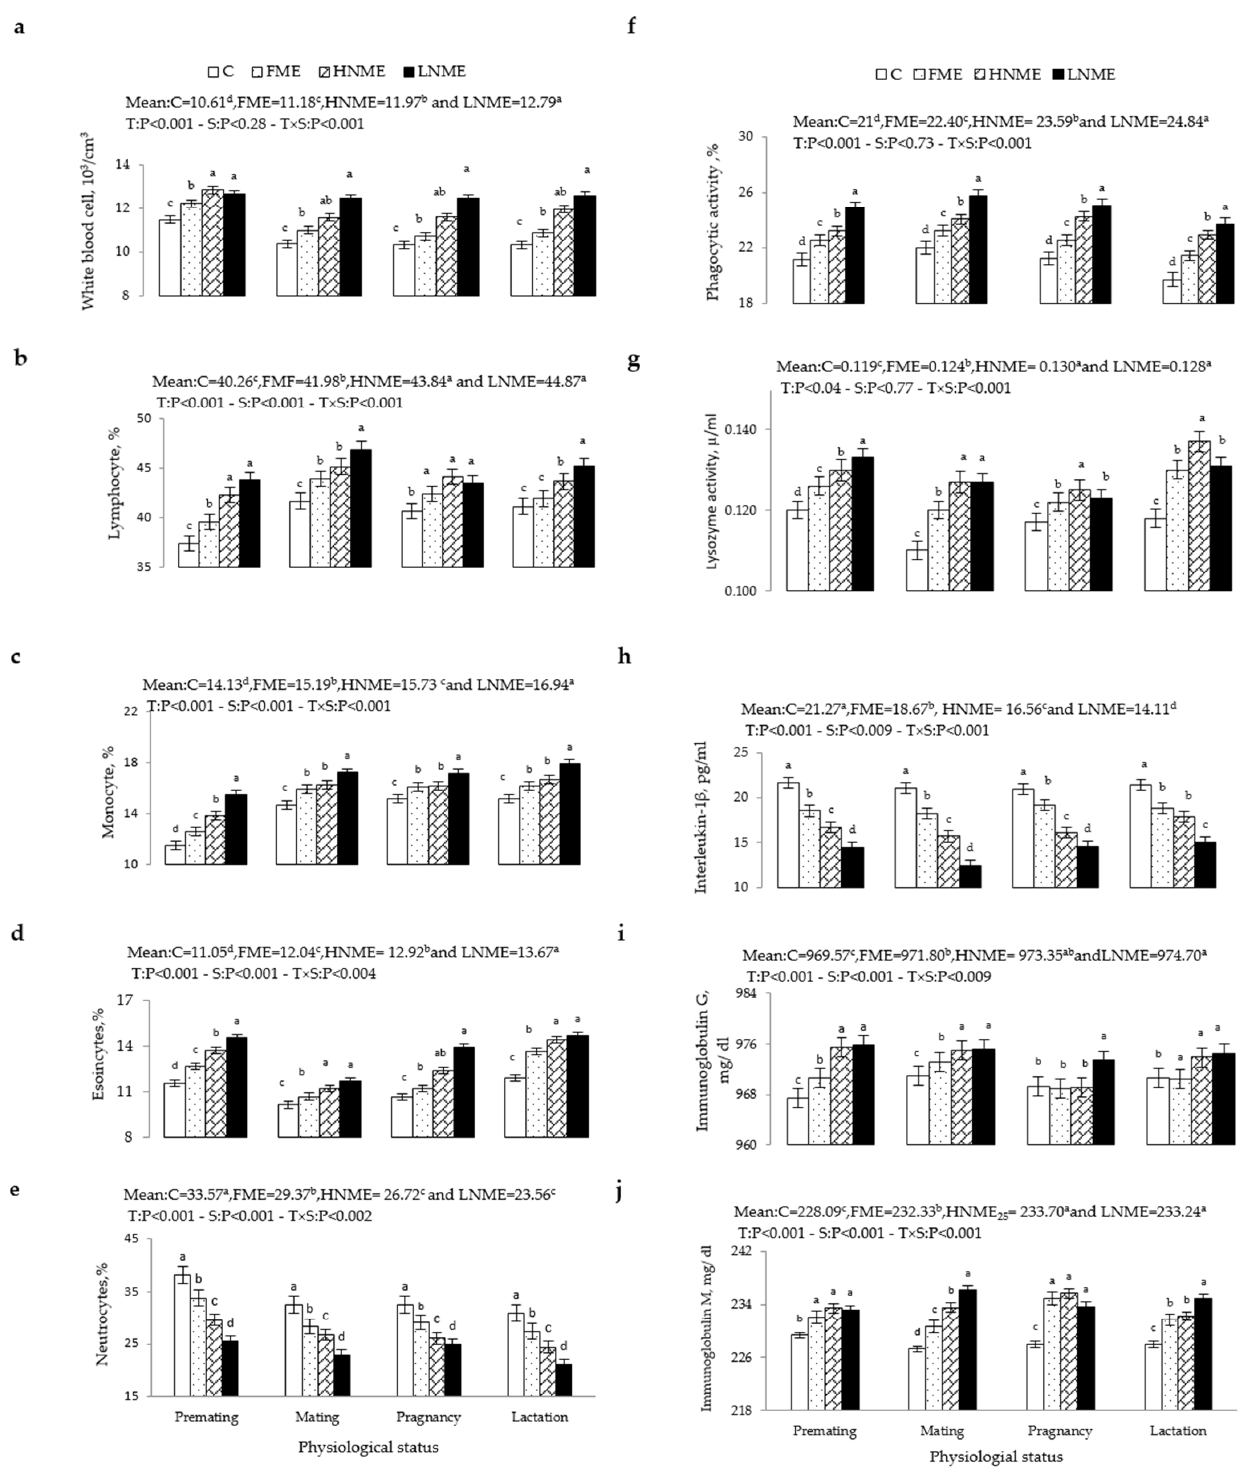
Figure 2. Means ( ± SEM) treatment by physiological status interaction effects on immunity variables; white blood cell ( a ), lymphocytes ( b ), monocytes ( c ), eosinocytes ( d ), neutro©es ( e ), phagocytic activity ( f ), lysozyme activity ( g ), interleukin-1 β ( h ), immunoglobulin G ( i ) and immunoglobulin M ( j ) of multiparous rabbit does supplemented with 0 mg/kg BW (C), 50 mg/kg BW free ME (FME), 25 mg/kg BW nano-encapsulated ME (HNME), and 10 mg/kg BW nano-encapsulated ME (LNME). The means of different treatments within the same physiological status with different lowercase letter superscripts differ significantly ( p <